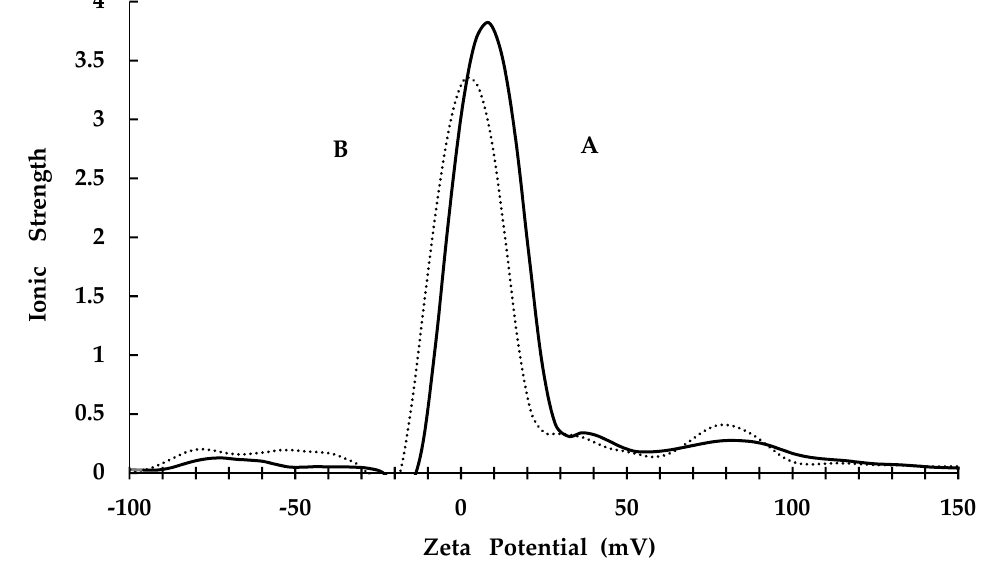
Figure 1. Zeta potential values (CKR12-PLGA is indicated by A, CKR12-PLGA-MCZ is indicated by B).